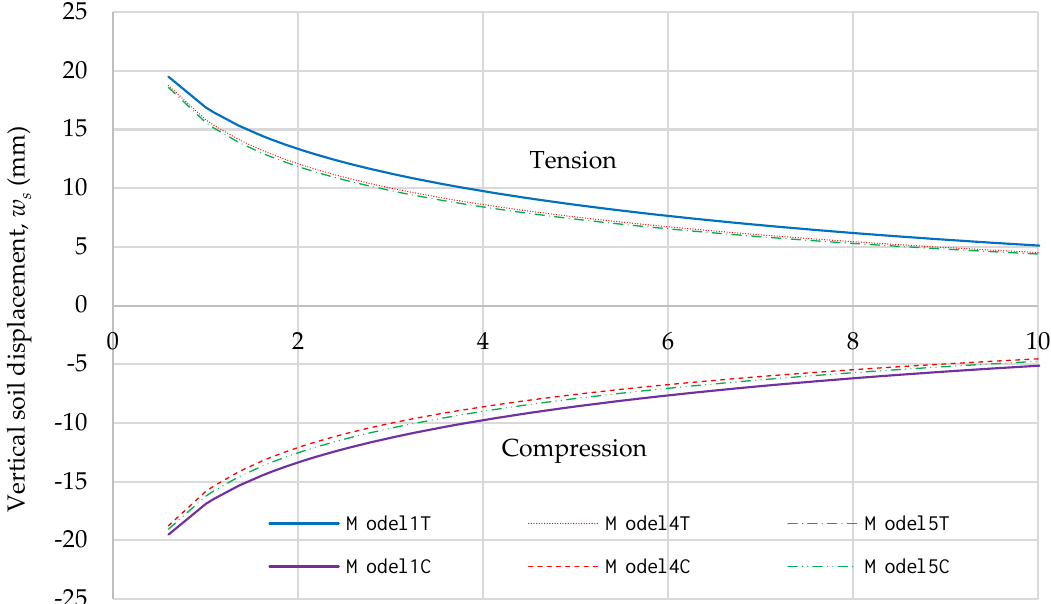
Figure 11. Soil displacement in the mid-depth level of the pile versus radial distance from pile center, from FE analysis.